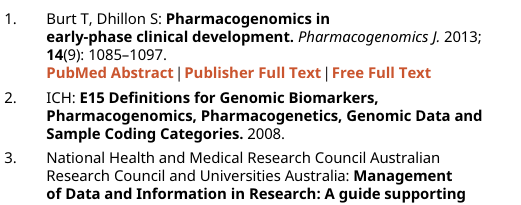
This project contains the following extended data: